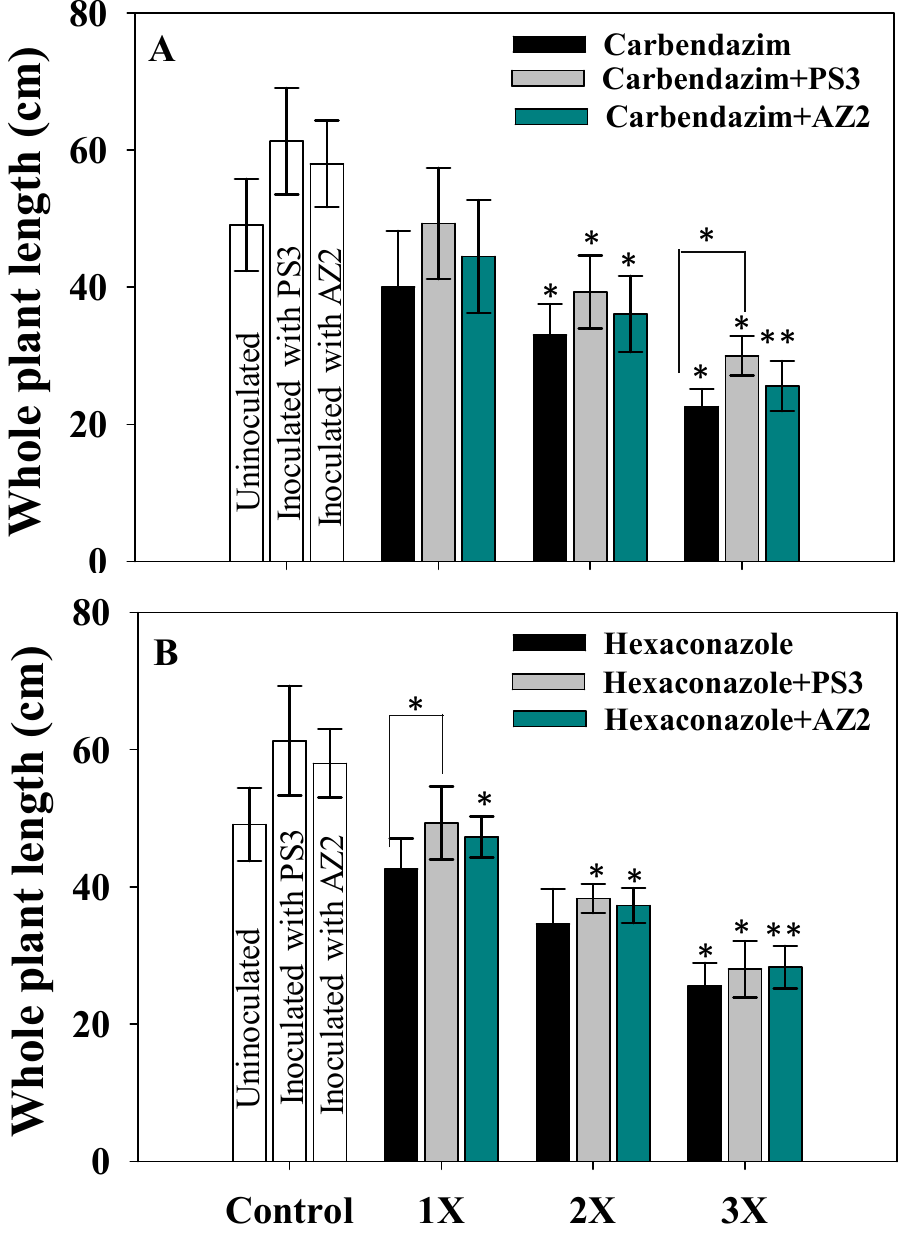
Figure 5. Bio-inoculation effect of Pseudomonas sp. PS3 and Pseudomonas sp. AZ2 on whole plant length (cm) of R. sativus plants grown in soil treated with varying concentrations of carbendazim ( A ) and hexaconazole ( B ). In these figures, histograms represent the mean value of three independent replicates ( n = 3) and error bars represent S.D. The asterisks * and ** denote statistical significance at p < 0.05 and p < 0.005, respectively computed by Student’s t -test. 1X, 2X and 3X denote the normal, two times and three times greater concentrations of fungicide.